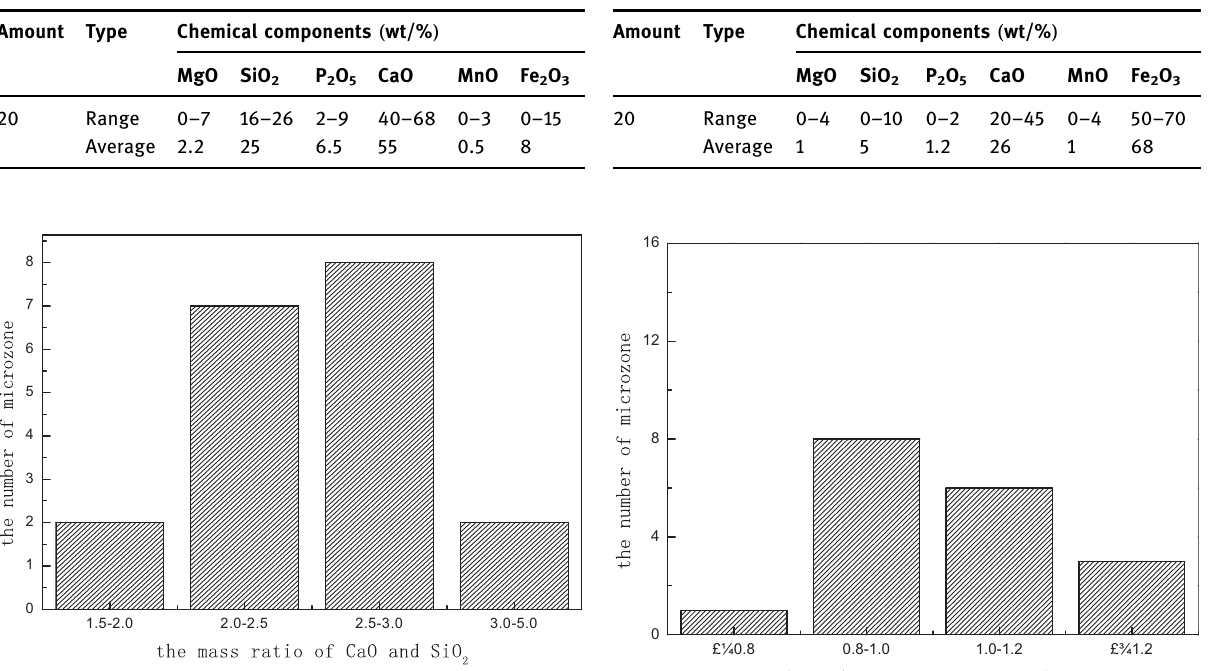
Figure 10: Molar ratio of Fe 2 O 3 to CaO in phase